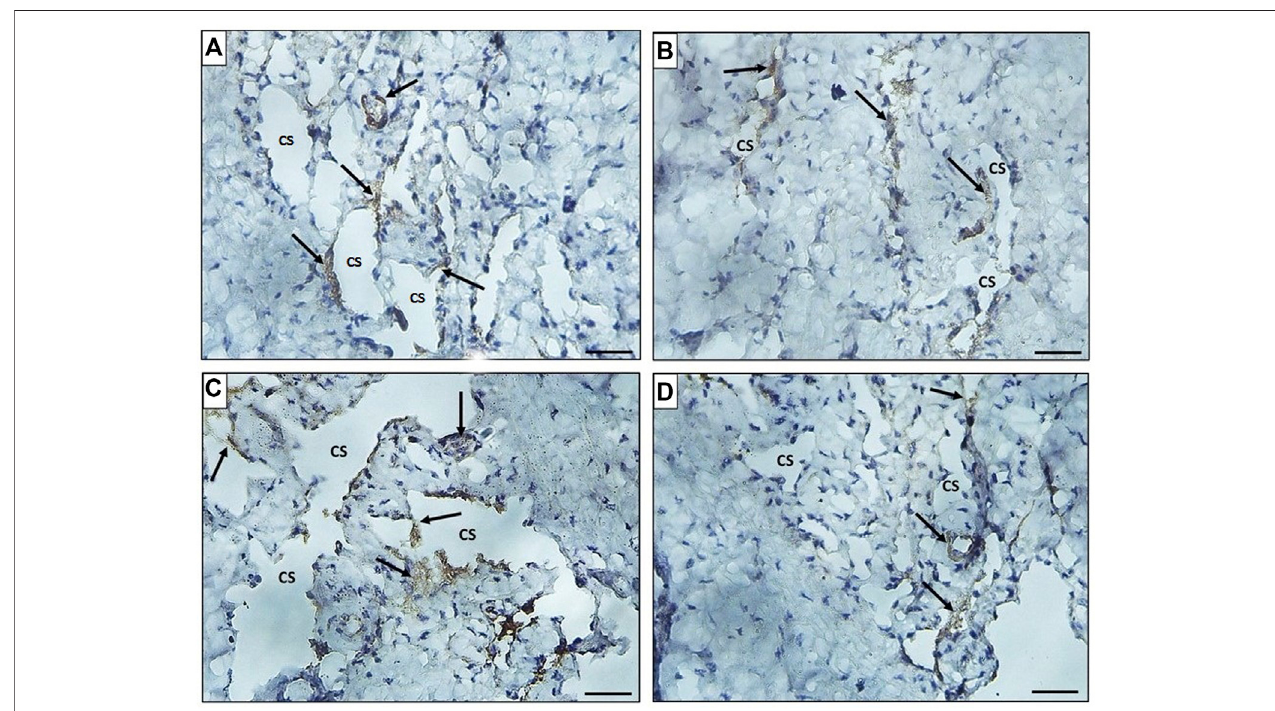
FIGURE 9 | Histological transverse sections of the penises of all rats in all groups immunohistochemically stained with anti-desmin antibody showing immunopositive cytoplasmic and nuclear reaction in smooth muscle cells around the cavernous spaces. The expression decreased in diabetic group (group II) (B) in comparison to the control group (group I) (A) and restoration of its expression was noticed in groups III and IV (C) and (D) , respectively. CS: cavernous spaces. Arrow: positively stained cells around the CS. X400. Scale bar: 50 μ m.